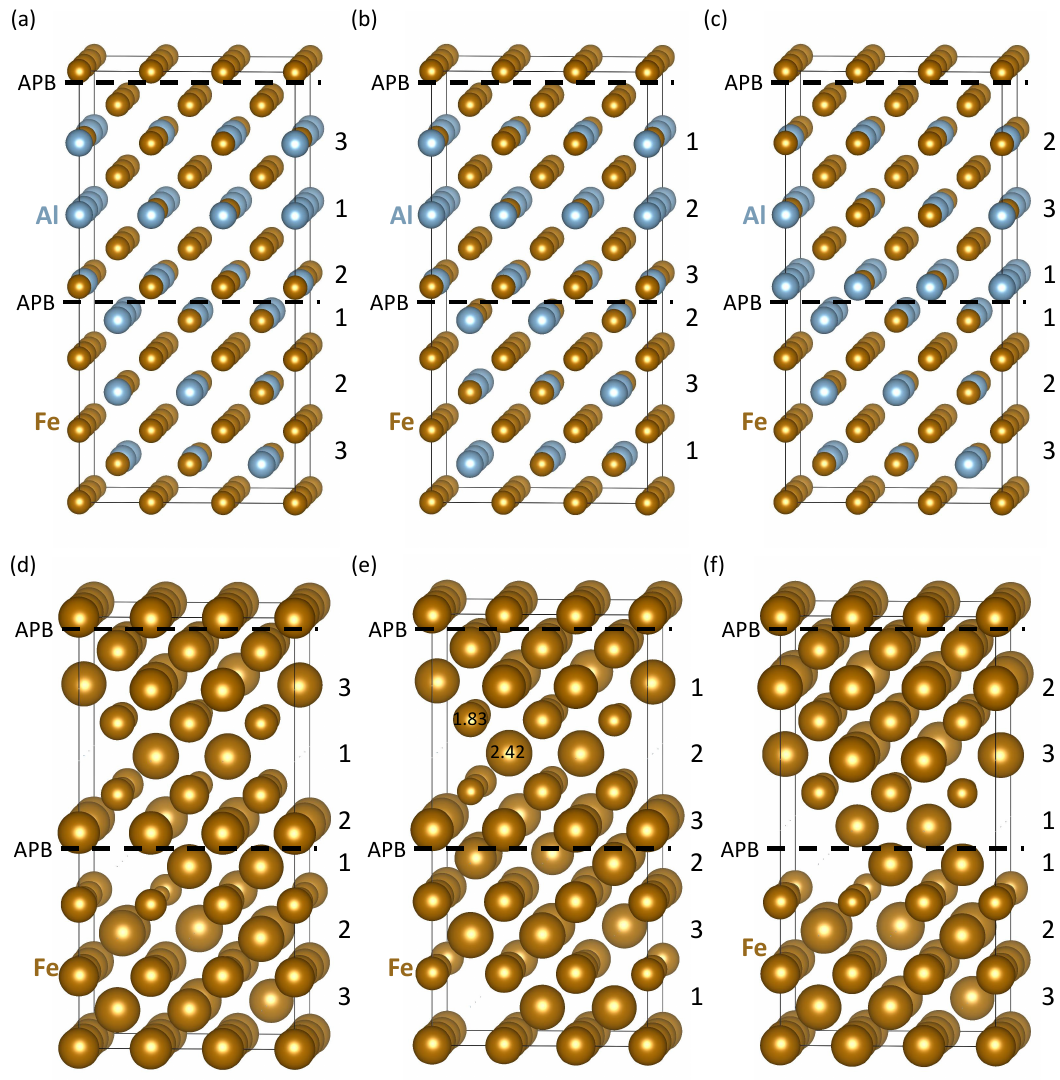
Figure 3. Schematic visualizations of three additional variants of sharp APBs with different compositions of two atomic planes containing both Fe and Al atoms. In particular, two Fe-Al planes above and below the APB in the middle of the supercell in Figure 1c contain 5 and 7 Al atoms, respectively, while those shown here contain 4 and 7 Al atoms in part ( a ), 4 and 4 Al atoms in part ( b ), and 7 and 7 Al atoms in part ( c ). The local magnetic moments of atoms corresponding to supercells ( a – c ) are shown in parts ( d – f ), respectively. The magnitude of local magnetic moments are visualized by the diameter of spheres representing atoms—two values in Bohr magnetons µ B are given in part ( e ) in order to show the scaling. Statistical information for each configuration is given in Table 1. The configurations in Figure 3 have higher percentages of Fe atoms with lower number of Al atoms (1–4 Al atoms) in the 1NN shell and lower percentages of Fe atoms with 5 and more Al atoms in the 1NN shell (compared with the APB-free B2 phase). The increase of magnetism is smaller because some of the Fe atoms with higher number of Al atoms in the 1NN shell have their moments antiparallel to the moments of other Fe atoms. There is thus an APB-induced change from a ferromagnetic state of the B2 phase of Fe 70 Al 30 to a ferrimagnetic